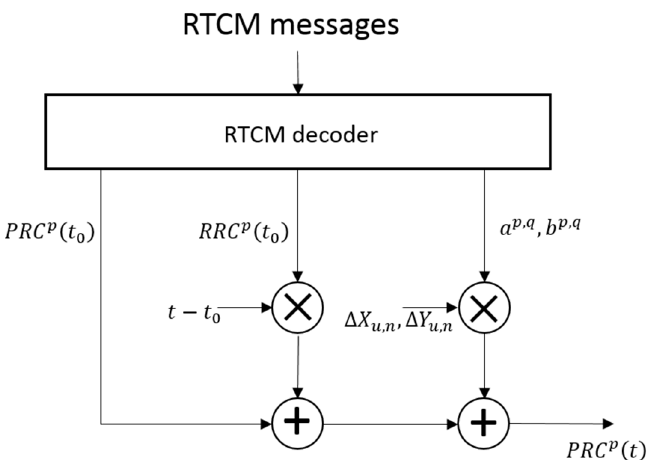
Figure 4. Flowchart for calculating pseudorange correction (PRC) in rover software of modified differential GNSS differential GNSS (DGNSS).